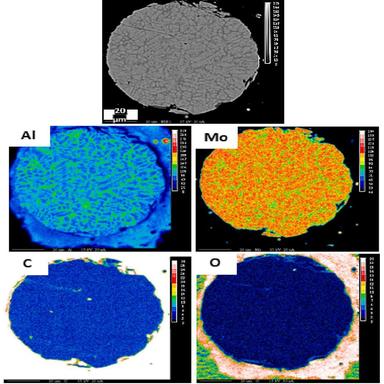
BSE image of a large, reacted composite particle and EPMA elemental mapping of Al, Mo, C, and O contents.